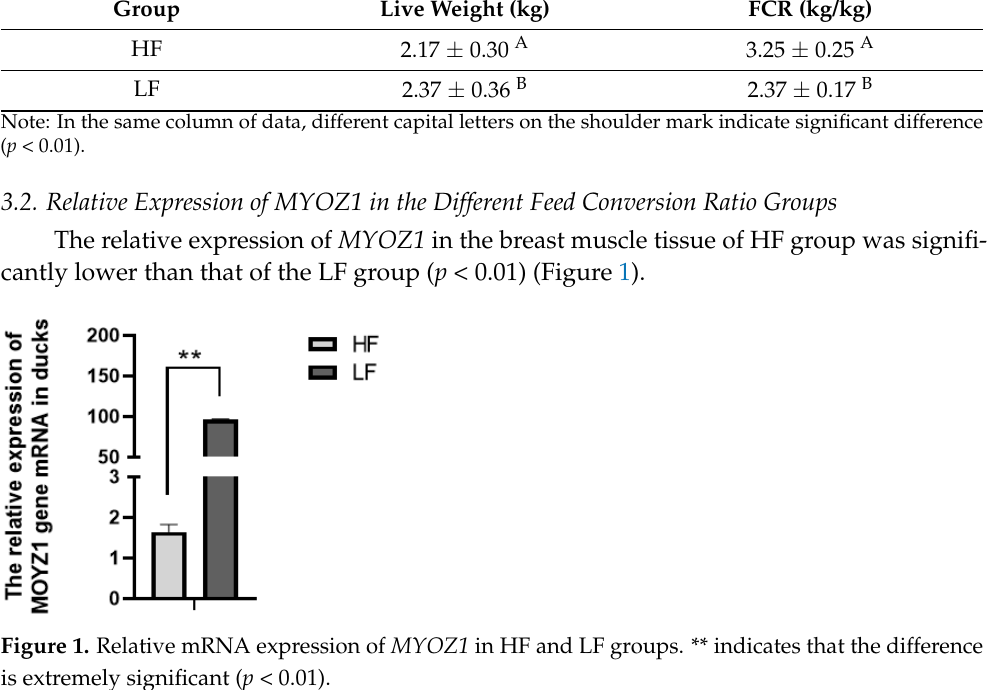
Table 3. Body weight and feed conversion ratio in the test groups. Group